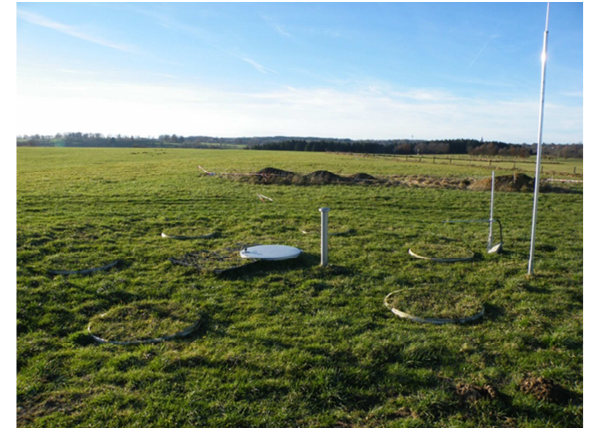
Figure 2. The lysimeter setup of the Rollesbroich study site (November